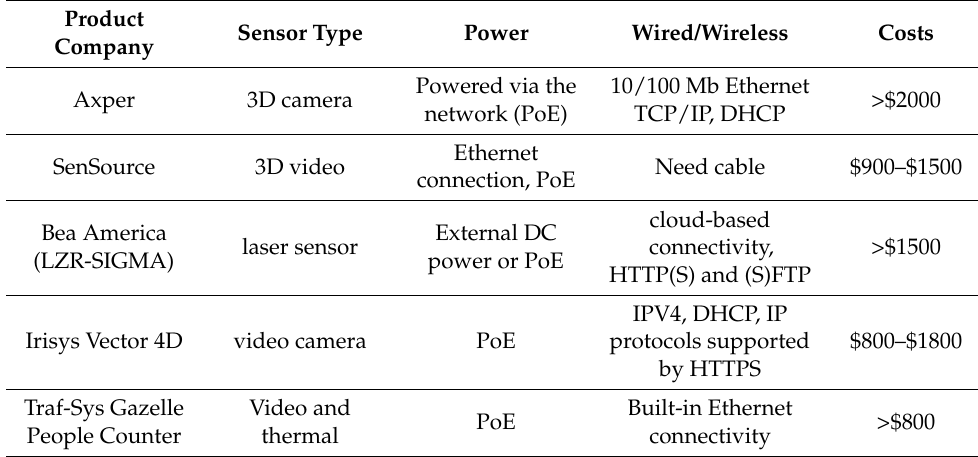
Table 1. Commercial people-counting sensors on the market.